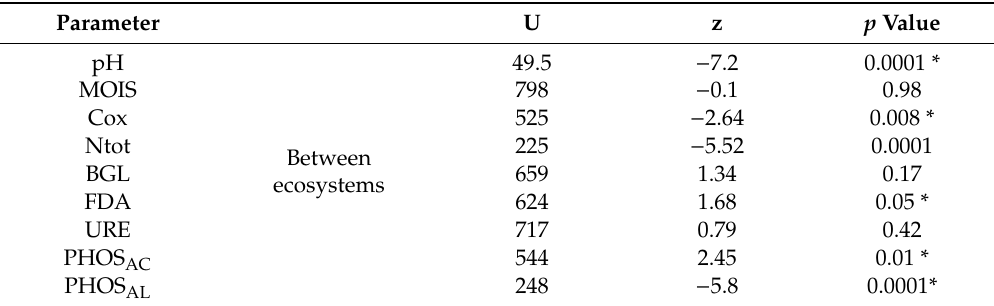
MOIS (soil moisture), Cox (soil organic carbon), Ntot (total nitrogen), FDA (fluorescein diacetate activity), BGL (beta-glucosidase activity), URE (urease activity), PHOSAL (alkaline phosphatase activity), PHOSAC (acidic phosphatase activity), * p < Table 2. The values of Mann–Whitney nonparametrical test for comparison soil characteristics between ecosystems (grassland and forest) regardless of the year and the invasion status (invaded, noninvaded sites).